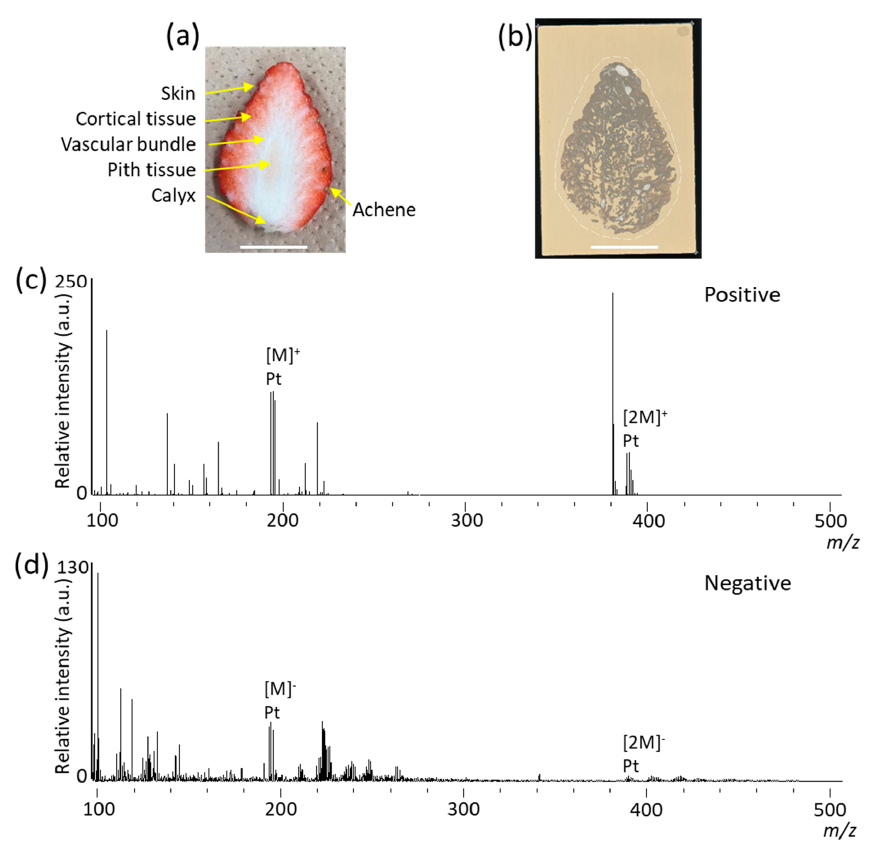
Figure 2. Mass spectra of strawberry fruit by blotting using desorption ionization using through-hole alumina membrane (DIUTHAME) chip in mass spectrometry imaging. ( a ) Optical image of the analyzed cross-section of strawberry fruit. ( b ) Optical image of DIUTHAME chip blotted with a cross-section of strawberry fruit. Dotted white line indicates the analyzed region. Scale bar = 20 mm. Mass spectra obtained using ( c ) positive and ( d ) negative ion modes. Peaks with platinum (Pt) are derived from Pt coated on the through porous hole alumina membrane.